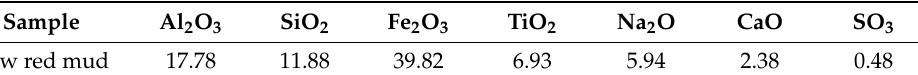
Table 1. Compositions of raw red mud (wt.%).